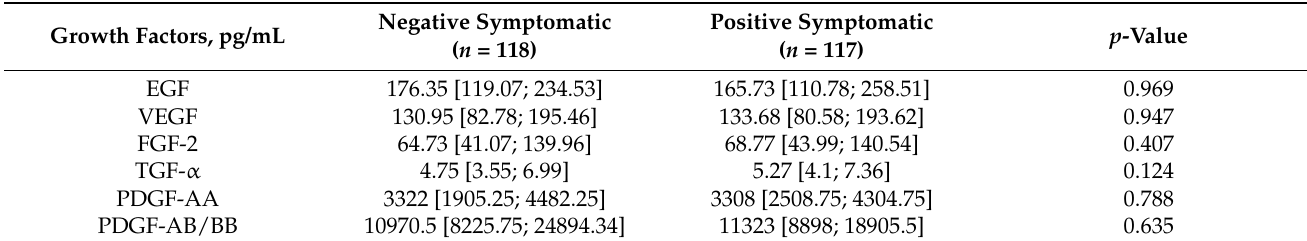
Table 5. Concentration of serum growth factors in patients with leading negative or positive symp- toms of schizophrenia (Me [Q1; Q3]).